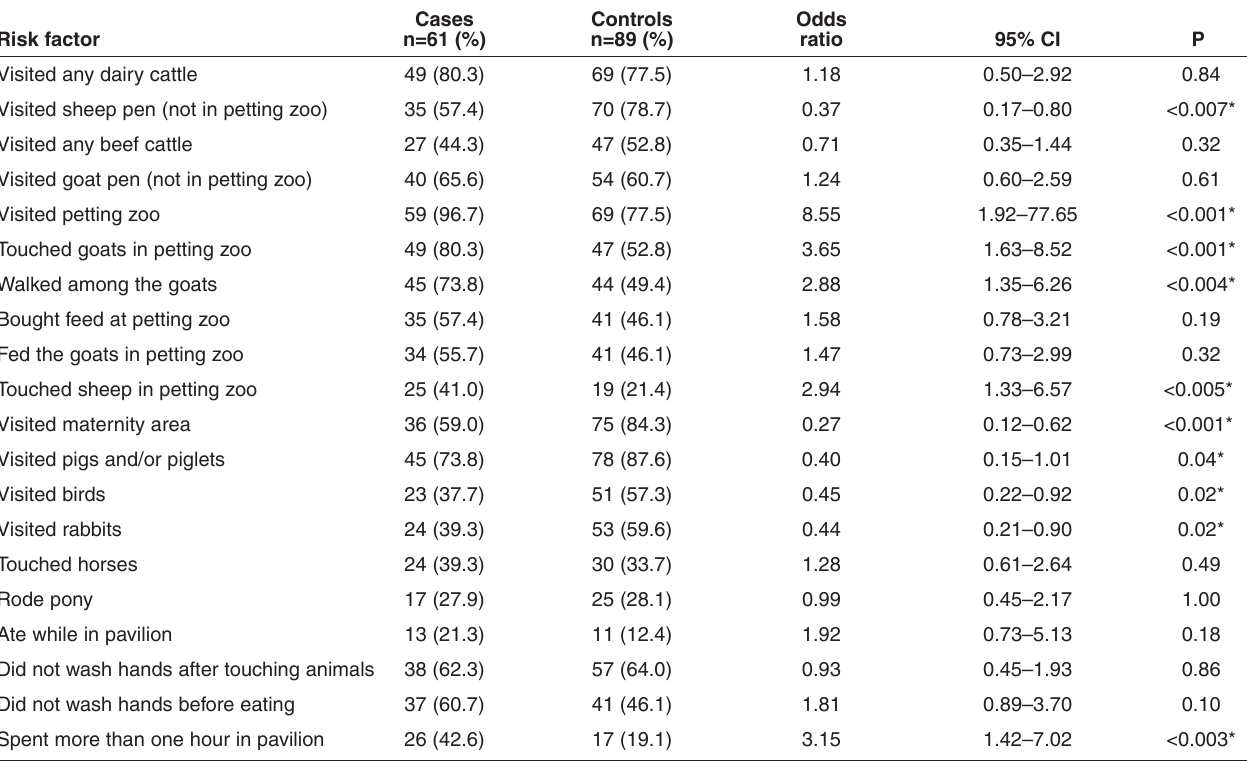
TABLE 3 Odds ratios associated with exposures at the agricultural pavilion at the fair, Middlesex-London, Ontario, 1999